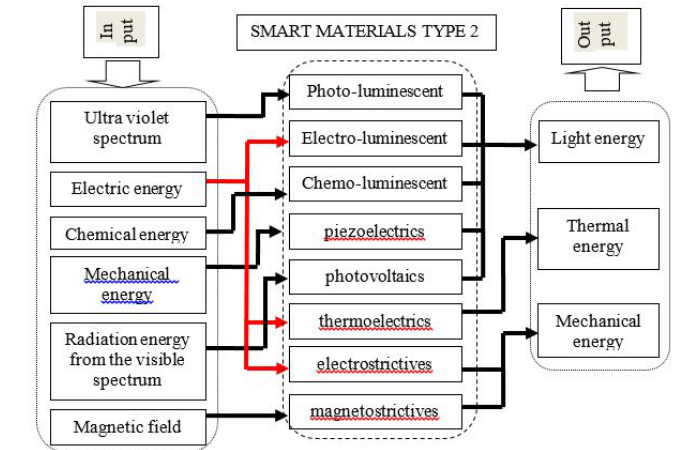
Figure 2. type 2 of smart materials that transforms energyfrom one form to another. (Sun, 2015), (Vavan, 2014), (Konarzewska, 2017),(Mahdavinejad,Bemanian & Khaksar, 2011) edited by the authors